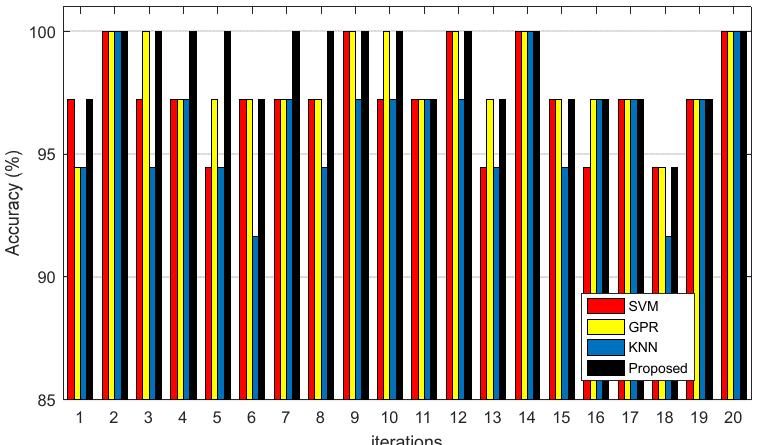
Figure 6. The distribution of samples belonging to each target class based on 3 features extracted by the SVD algorithm in BRATS2014 .